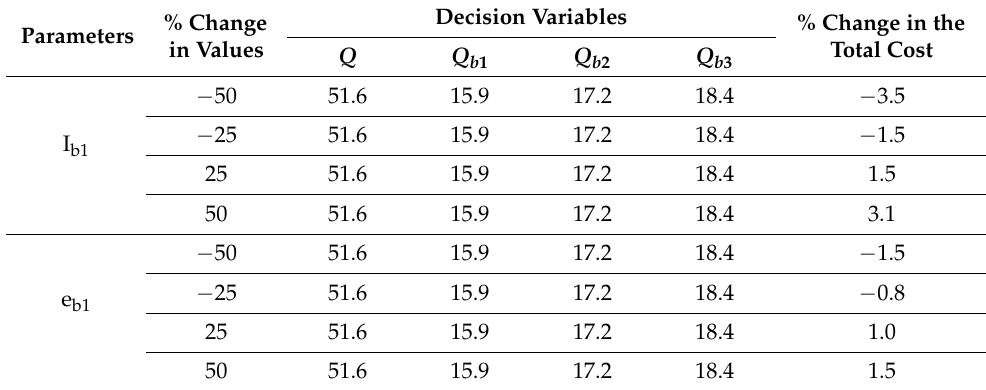
Figure 2 is a graphical representation of our sensitivity analysis, based on data given in Tables 8 and 9, showing that the most dispersed lines had a high impact on the total cost of the supply chain (SC). By making small changes to these, the sensitive variables caused drastic variations in the total cost of SC.